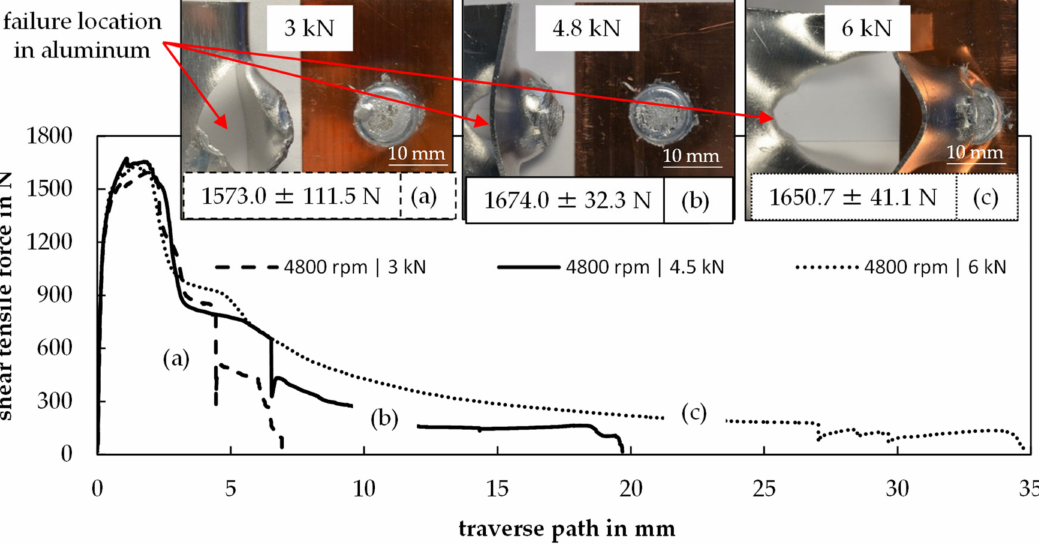
Figure 13. Influence of process force on the force-path curves and failure patterns of the welded